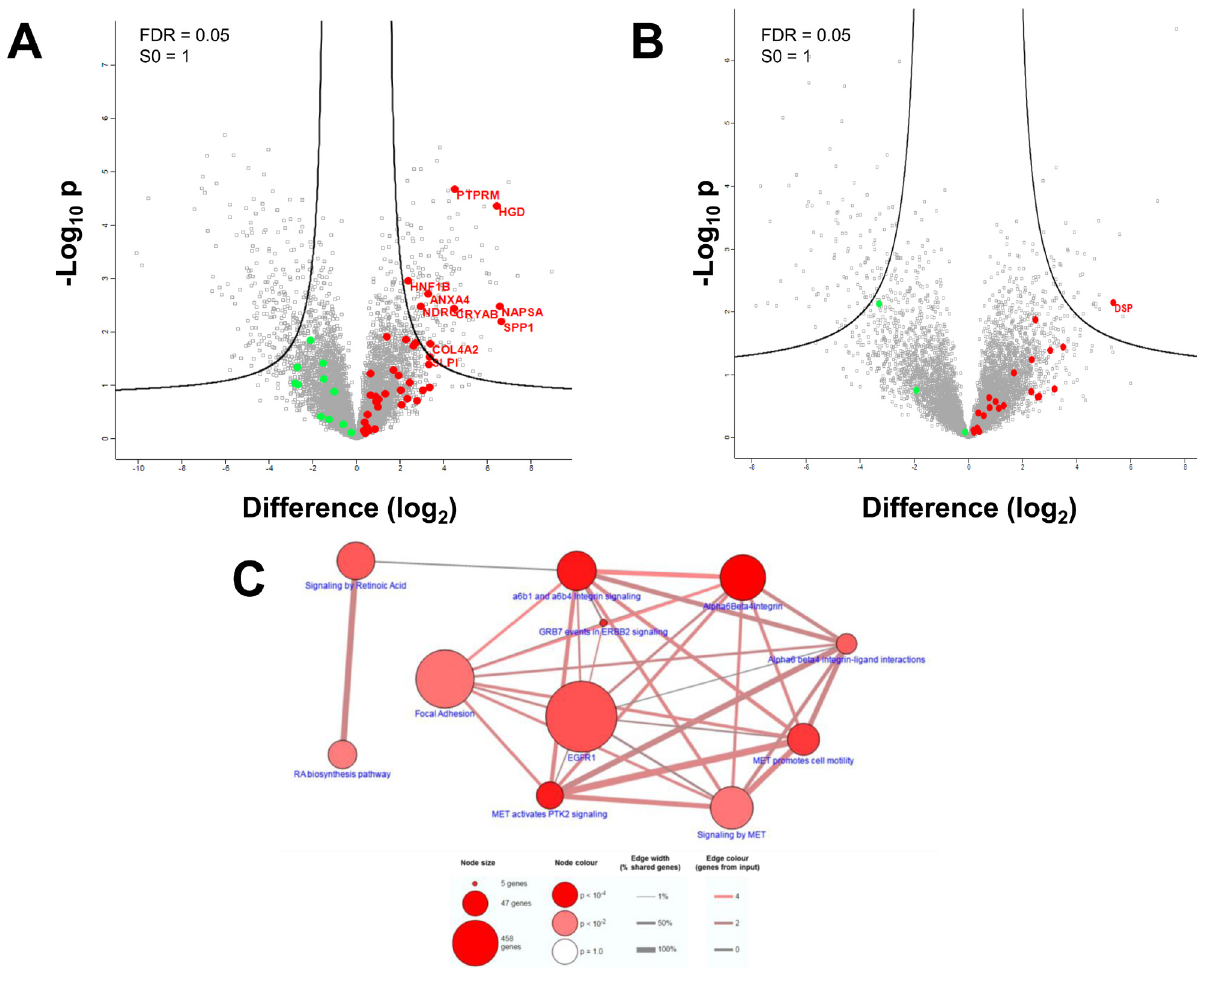
Figure 4. Integration with genomics and disease signature analyses. Volcano plot of CC versus EMT proteomes ( A ) and EC versus EMT proteomes ( B ) overlaid with concordant genomic features. The black lines denote statistical significance. ( C ) depicts overrepresented pathways identified in the ‘disease signature’ derived for